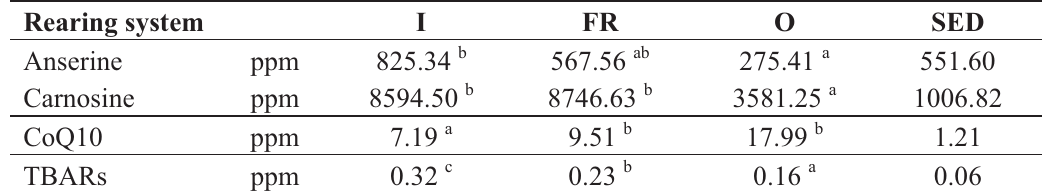
Table 4. Effect of rearing system on histidyl dipeptides, TBARs and CoQ10 contents of Longissimus dorsi of